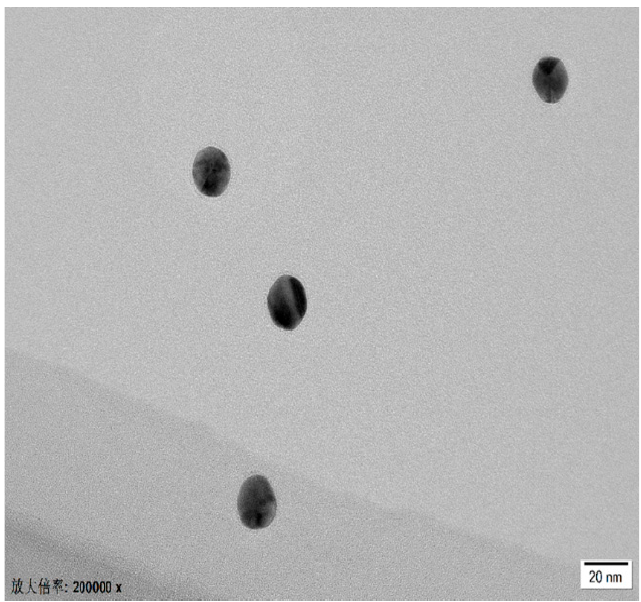
Figure 5. HR-TEM image at 20 nm scale with 200K× magnification, showing the characteristics of the colloidal AuNPs.